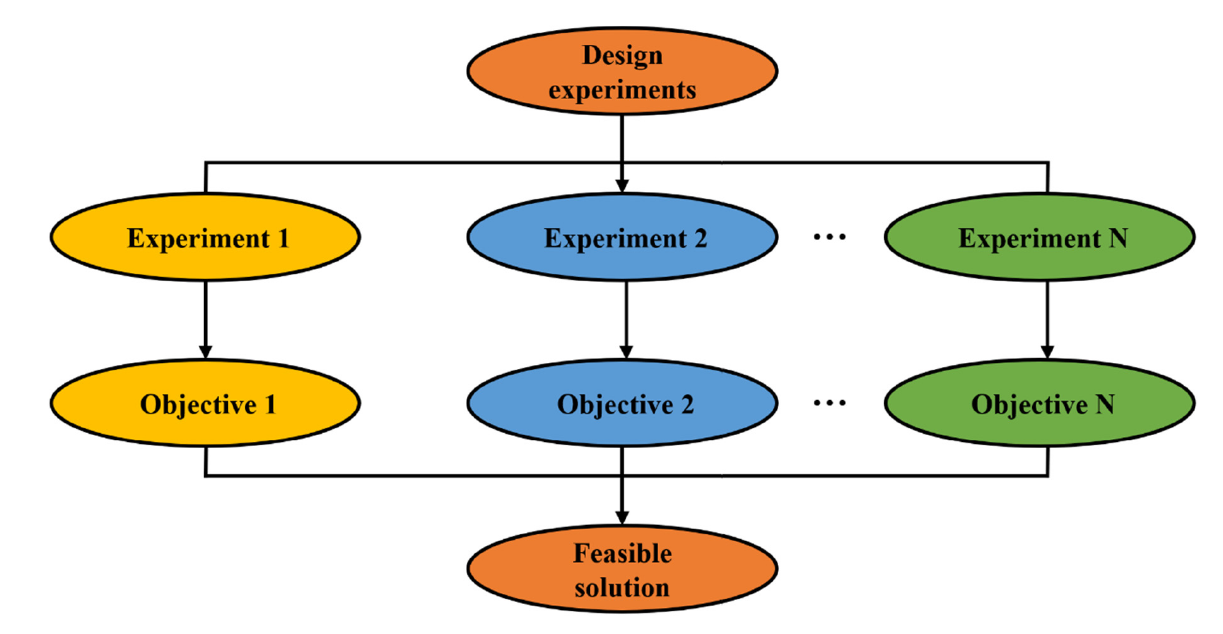
Figure 2. Performance-based approach.